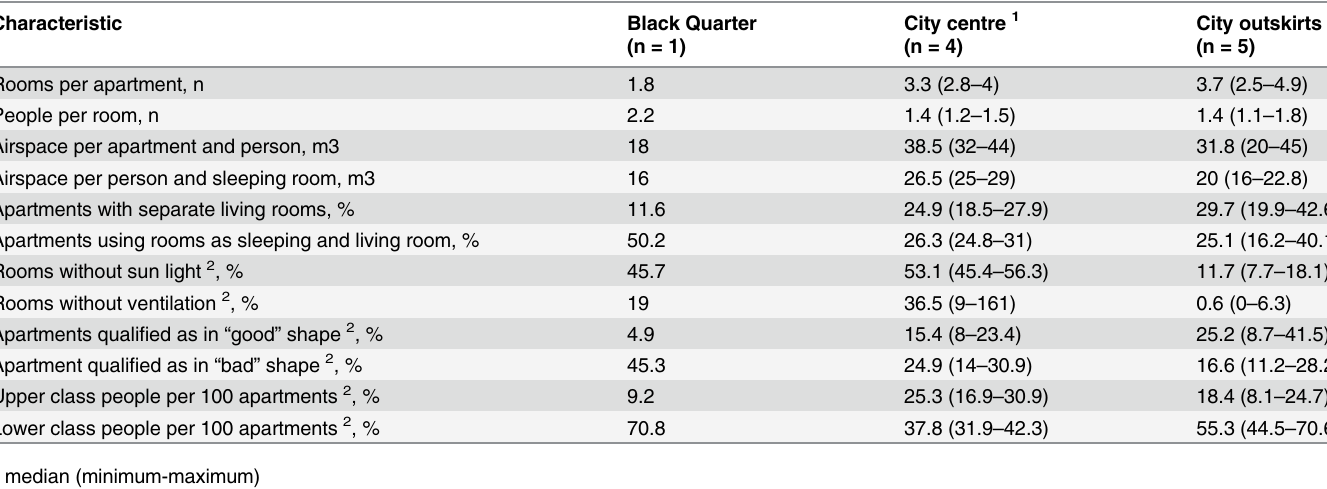
TB mortality correlated positively with the number of persons per room (r = 0.69, p = 0.026, S5 Fig), with the percentage of rooms that did not have direct day light (correlation coefficient r = 0.72, p = 0.020, Fig 3A), and negatively with the number of windows per apartment (r = -0.79, p = 0.007, Fig 3B). TB mortality was also correlated with population density in the quarters (r = 0.77, p = 0.014), number of houses per km 2 in the quarters (r = 0.81, p = 0.005), percentage of apartments in which people lived and slept in the same room (r = -0.84, p = 0.002; S6 – S8 Figs). Table 1. Living conditions in the ten quarters of the city of Bern around 1900 [19], comparing the Black Quarter, the quarters of the city centre (excluding Black quarter), and the city outskirts. Characteristic Black Quarter City centre 1 City outskirts